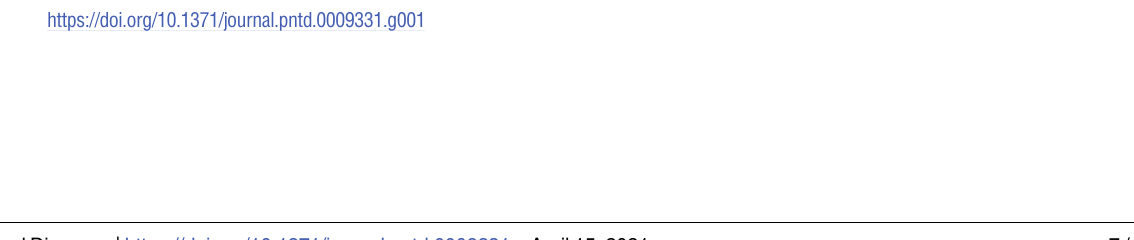
PLOS NeglectedTropical Diseases | https://doi.org/10.1371/journal.pntd.0009331 April 15,